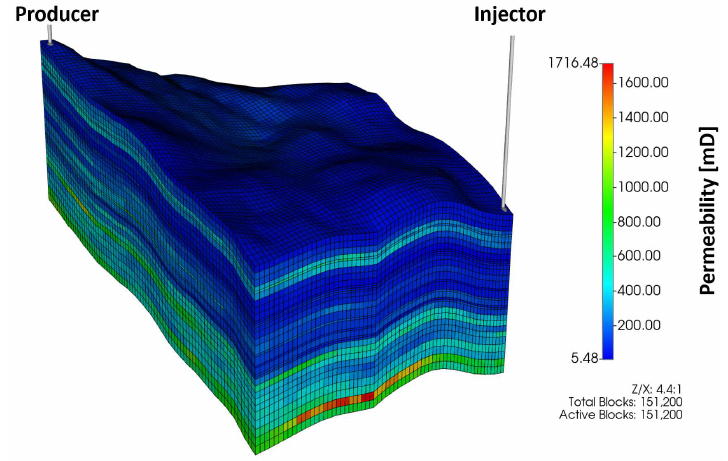
6 of 23 Figure 1. 2D synthetic reservoir cross-section showing the geologic layers, grid discretization, per- meability distribution, and well completion. For consistency, we define two dimensionless ratios that capture the production and injection rates and the pressure at which EGR has commenced. These ratios are defined as: • Productivity ratio —is the ratio of the production rate to the injection rate. •